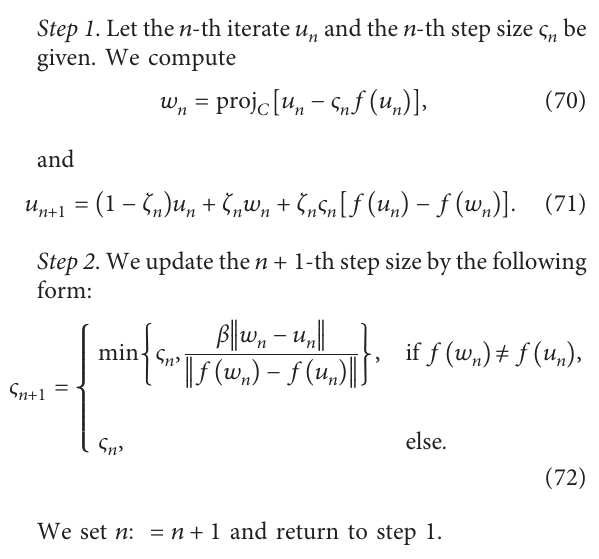
Algorithm 2. Initialization: let u set n � 0.